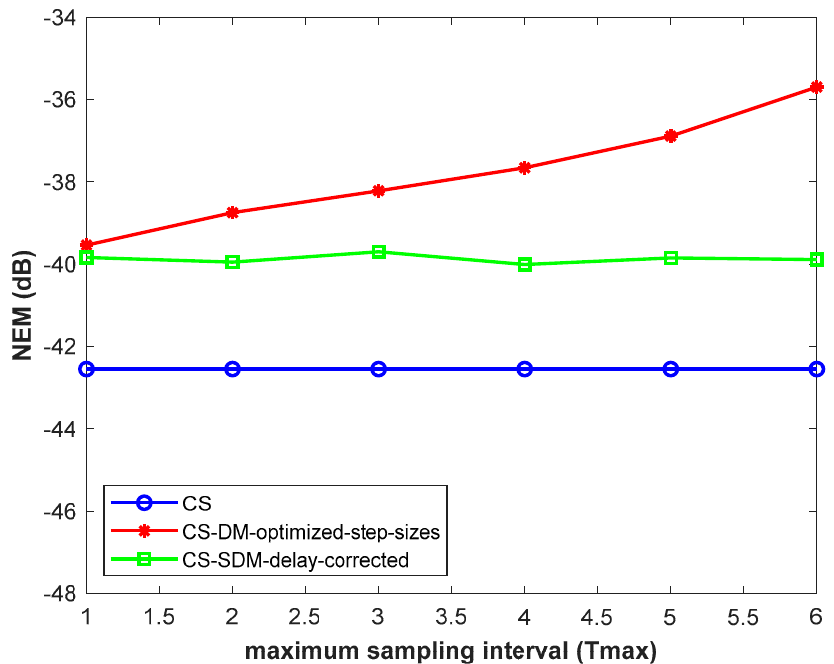
Figure 13. Performance of CS-SWL localization systems in terms of localization NEM versus maxi- mum sampling interval ( T max ) under noise-free conditions (neither measurement nor transmission noise). Results are averaged over 100 realizations.